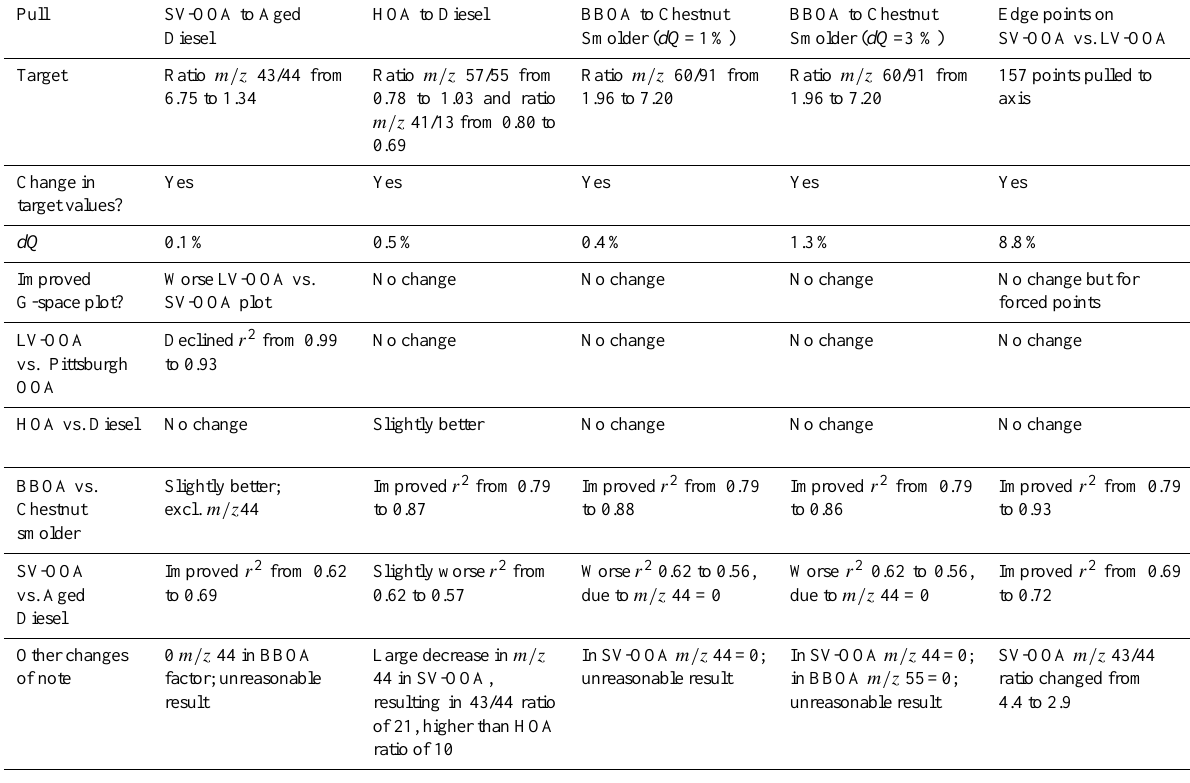
Table 2. Summary of pulls on the four-factor solutions, all with a maximum allowed dQ of 1%, except for one iteration with BBOA to Chestnut smolder ( dQ =3%), and except for the edge points pull, which had a total allowed dQ of 31%, or 0.2% per point with a total of 157 points.